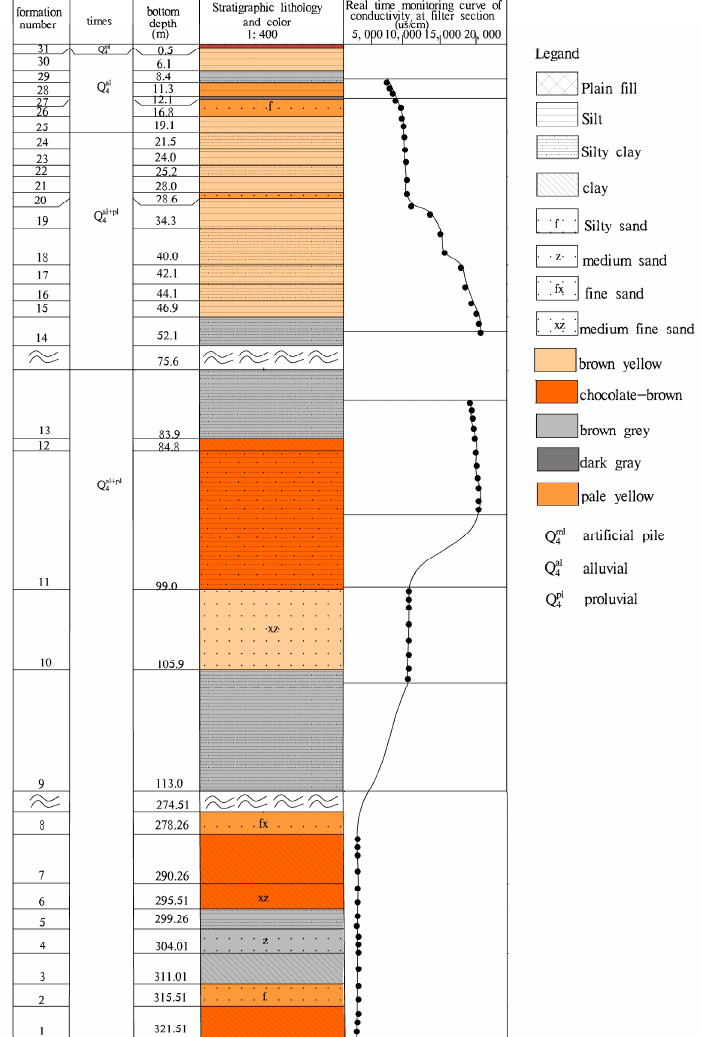
Figure 2. The shallow stratum histogram of a 321 m profile and groundwater conductivity at different depths.